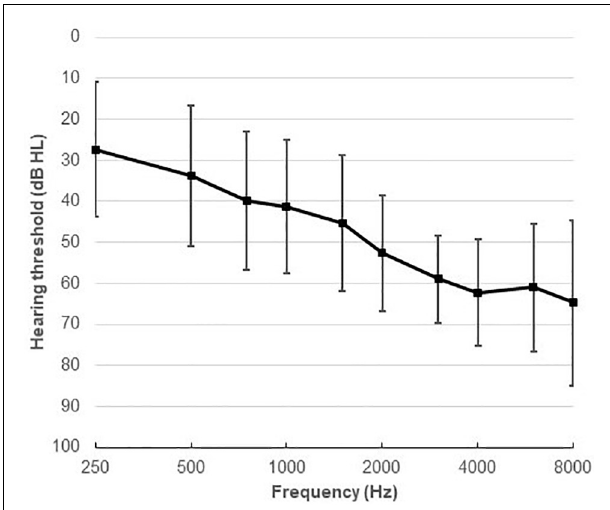
FIGURE 1 | Average audiometric thresholds (mean and SD) at octave and inter-octave frequencies across 250–8,000